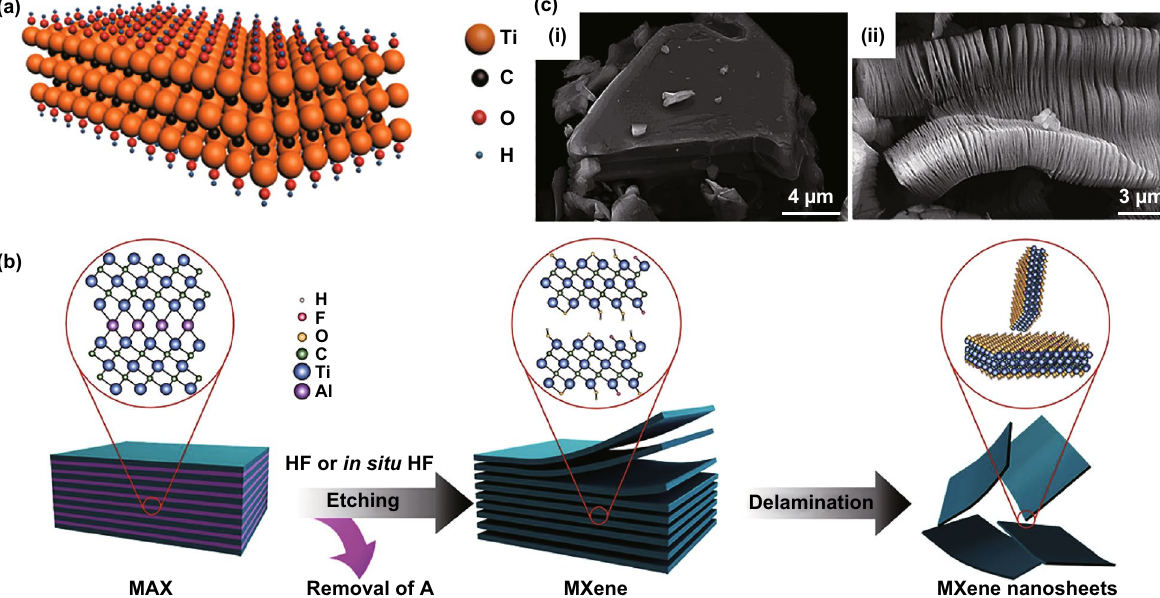
Fig. 2 Structure of Ti 3 C 2 T x . a Atomic composition model of Ti 3 C 2 T x [25]. b Schematic diagram of the process for etching and delamination of Mxene [51]. c Scanning electron microscopy (SEM) images of Ti 3 AlC 2 particle and Ti 3 C 2 T x [23]. Reproduced with permission from Refs.